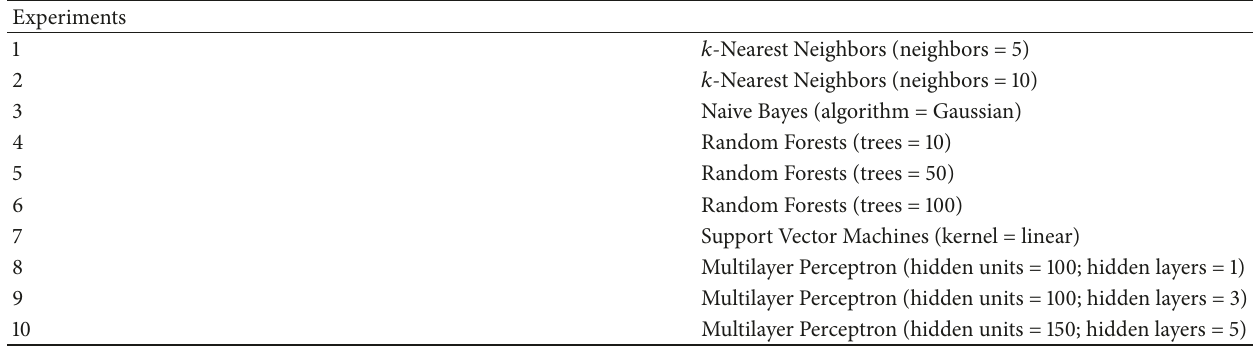
Table 3: List of experiments conducted in the research.